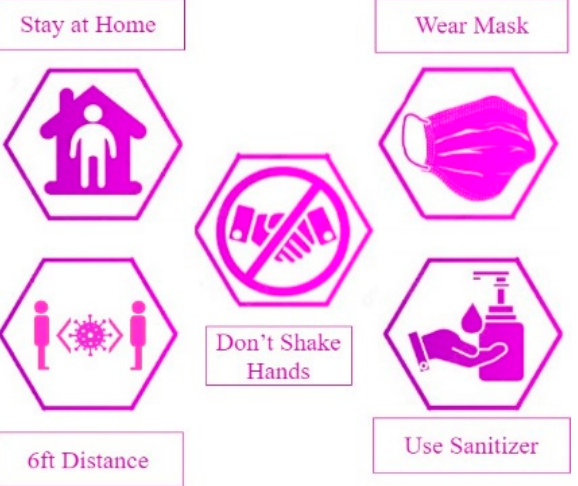
Figure 1. World Health Organization (WHO) recommended Standard Operating Procedures (SOPs) for COVID-19.